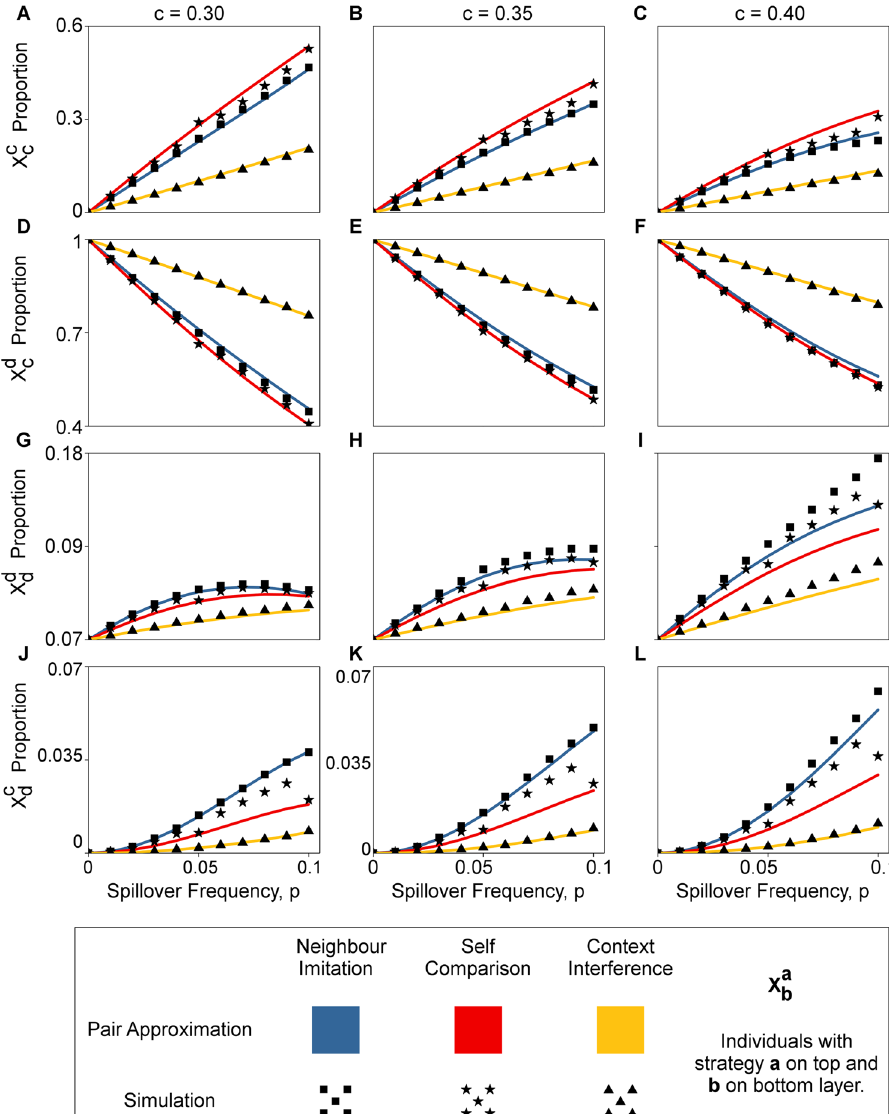
Figure 3. Microscopic characteristics of spillover modes. Figure compares proportion of individual top-bottom strategy combinations of each spillover mode for the parameters in Fig. 2, with different scales on the vertical axes. Each spillover mode differs in their microscopic characteristics. In ( A – C ), self comparison has the highest proportion of individuals cooperating on both layers, X cc . In ( D – F ), context interference has the highest proportion with the payoff maximizing strategy profile X cd . While in ( G – L ), neighbour imitation has the largest X dd and X dc proportions. Parameters: n = 3600, m = 4, b = 1, β = 0.2, α = 0.5. Simulations: 6 × 10 6 time steps, averaged over 100 runs. c is the cost of